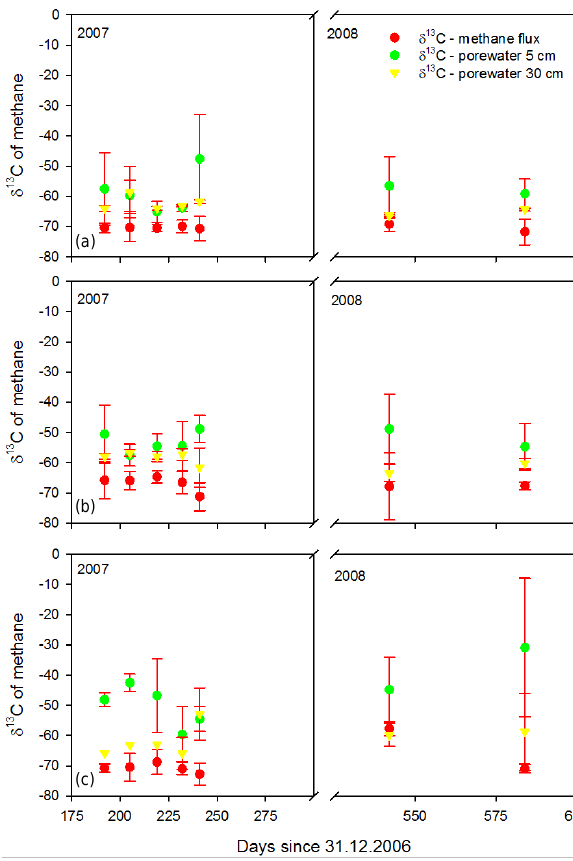
Figure 7. Profiles of porewater δ 13 C-CH 4 of wetlands at the Seida site in June (red) and August (green) 2008. Yellow and blue verti- cal lines represent δ 13 C of CH 4 emitted during June and August,